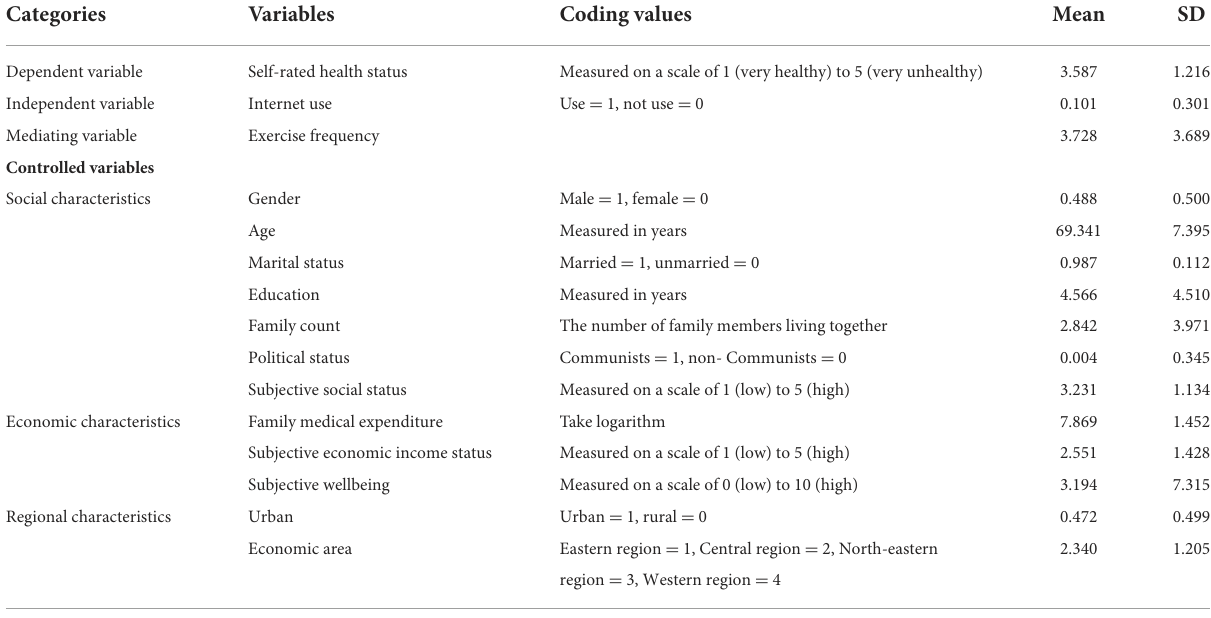
TABLE 1 Descriptive statistical results of key variables.